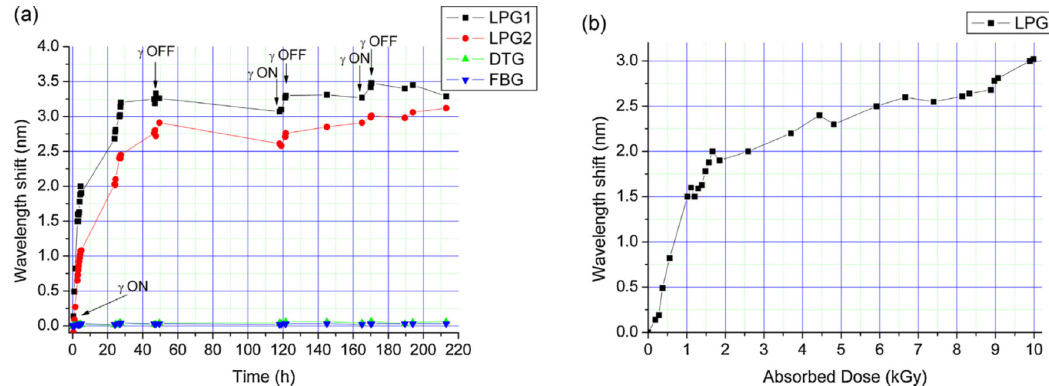
Figure 3. Gamma irradiation of CO 2 -written LPGs: resonance wavelength shift versus ( a ) time and ( b ) dose. © 2015 Elsevier. Reprinted with permission from [73].